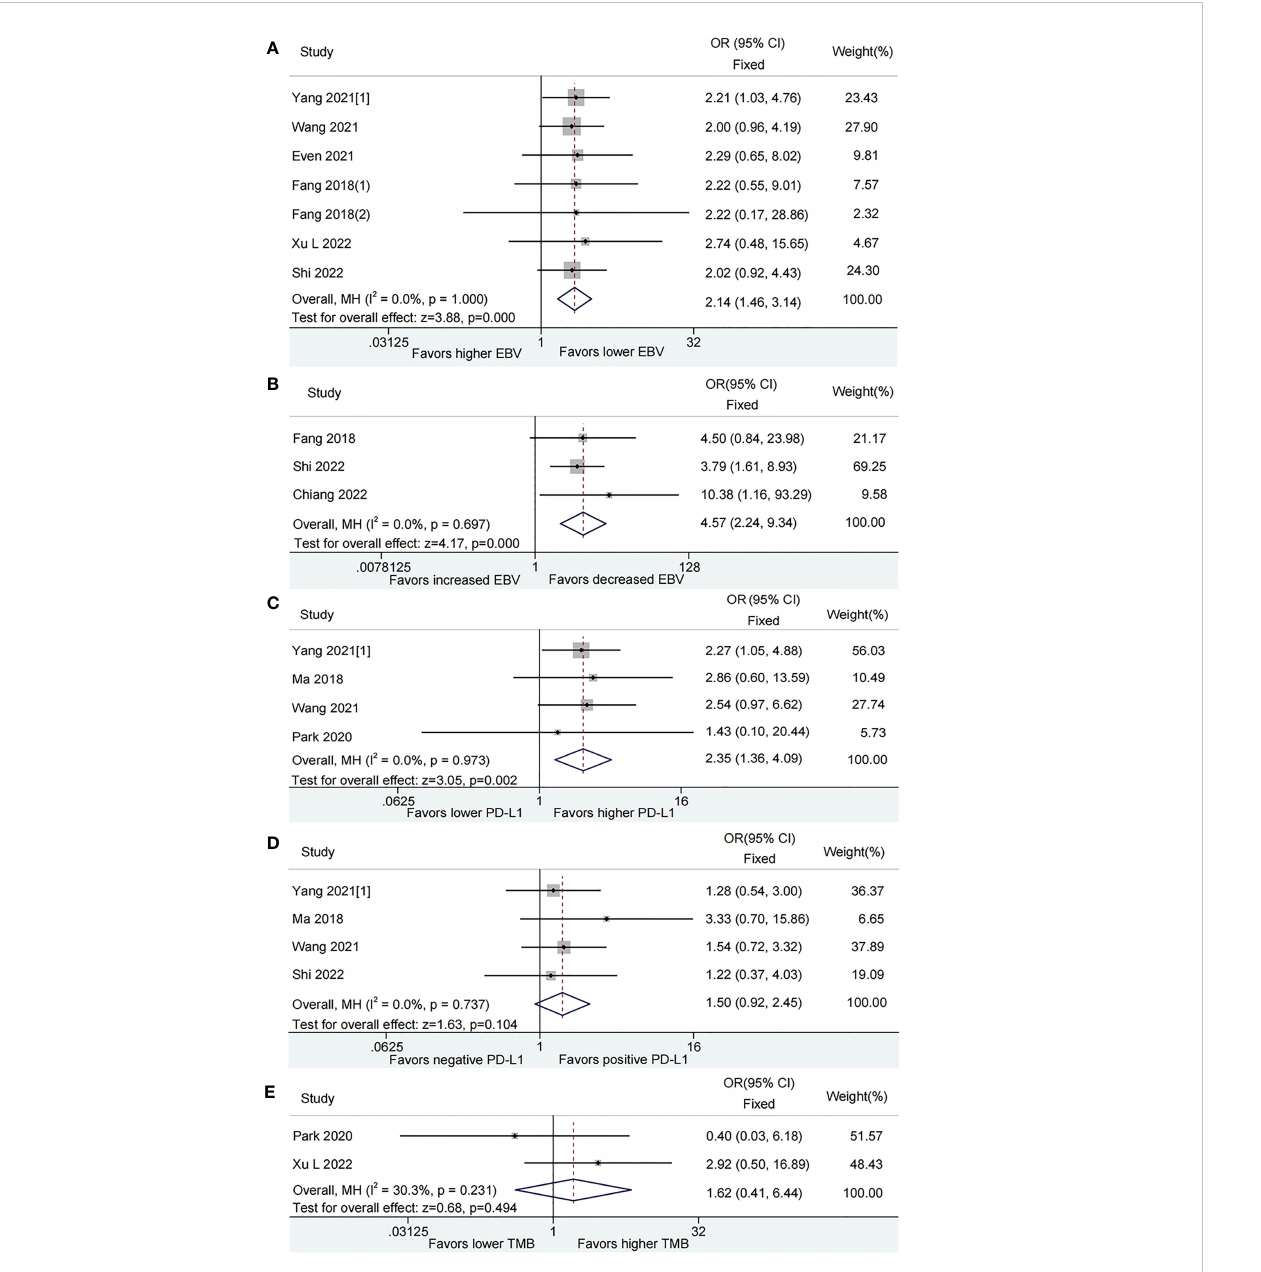
FIGURE 2 Meta-analysis of the association between biomarkers and objective response rate (ORR). (A) baseline plasma Epstein-Barr virus (EBV) DNA level and ORR; (B) Dynamic plasma EBV DNA load during immunotherapy and ORR; (C) programmed cell death-ligand 1 (PD-L1) expression [higher vs. lower] and ORR; (D) PD-L1 expression [positive vs. negative] and ORR; (E) tumor mutation burden (TMB) and